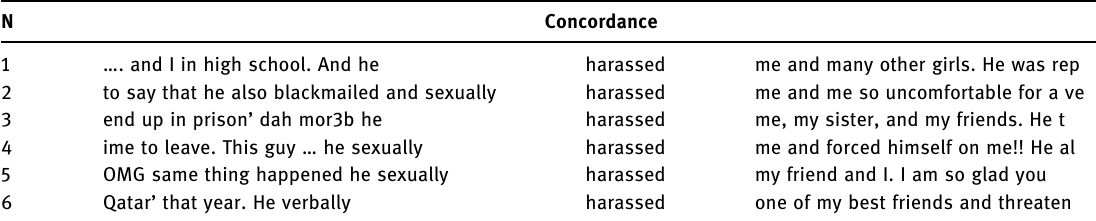
Table 31: Concordance lines for